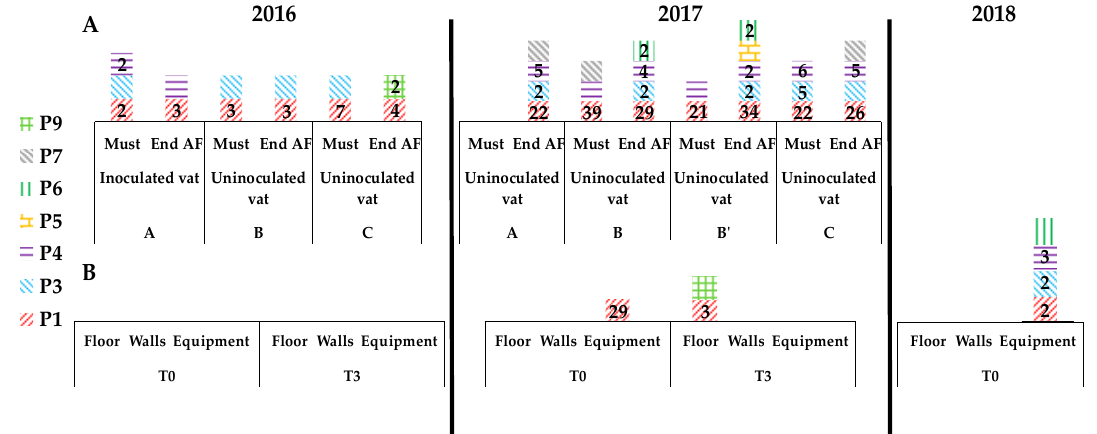
Figure 2. Persistence of strains of S. cerevisiae originated from Pied de Cuve (PDC) in the new winery studied during the three vintages: ( A ) In followed vats during the fermentations and ( B ) on WREs. Only the number of isolates per strain ≥ 2 is noted.